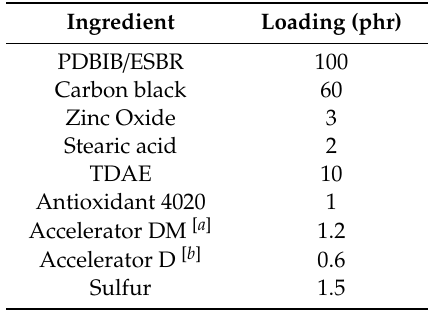
Table 3. Formulation for the PDBIB / CB and ESBR / CB nanocomposites.